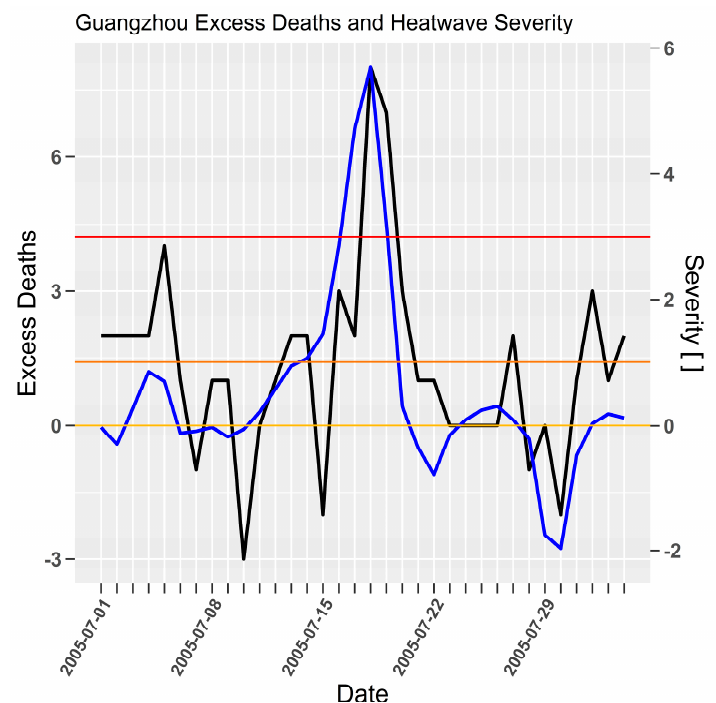
Figure 9. Guangzhou severity (blue) and excess mortality (black) for 2005 heatwave. Daily excess deaths (Jun Yang et al. [40] (p. 650, Figure 1)) and severity [] on left and right y -axes respectively.